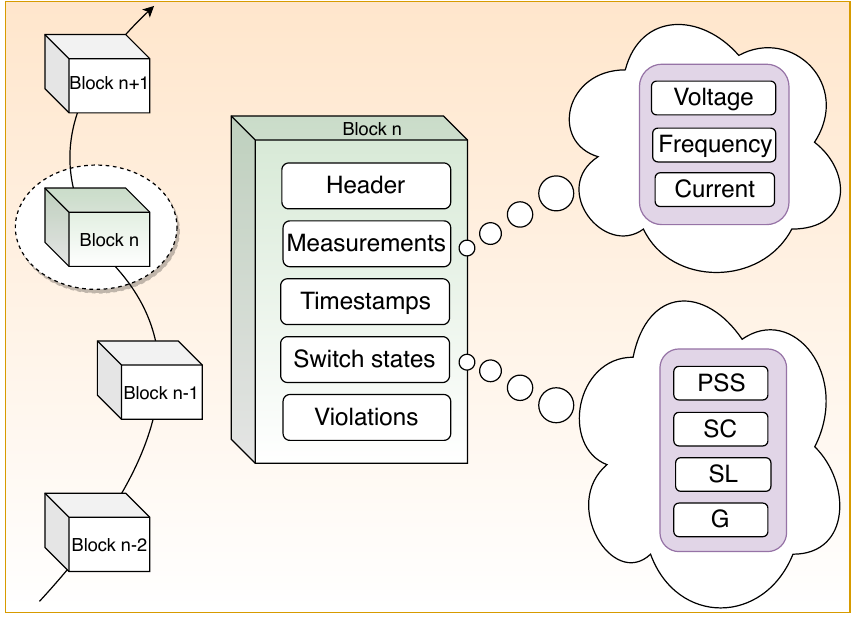
Figure 10. Block structure for power generation and